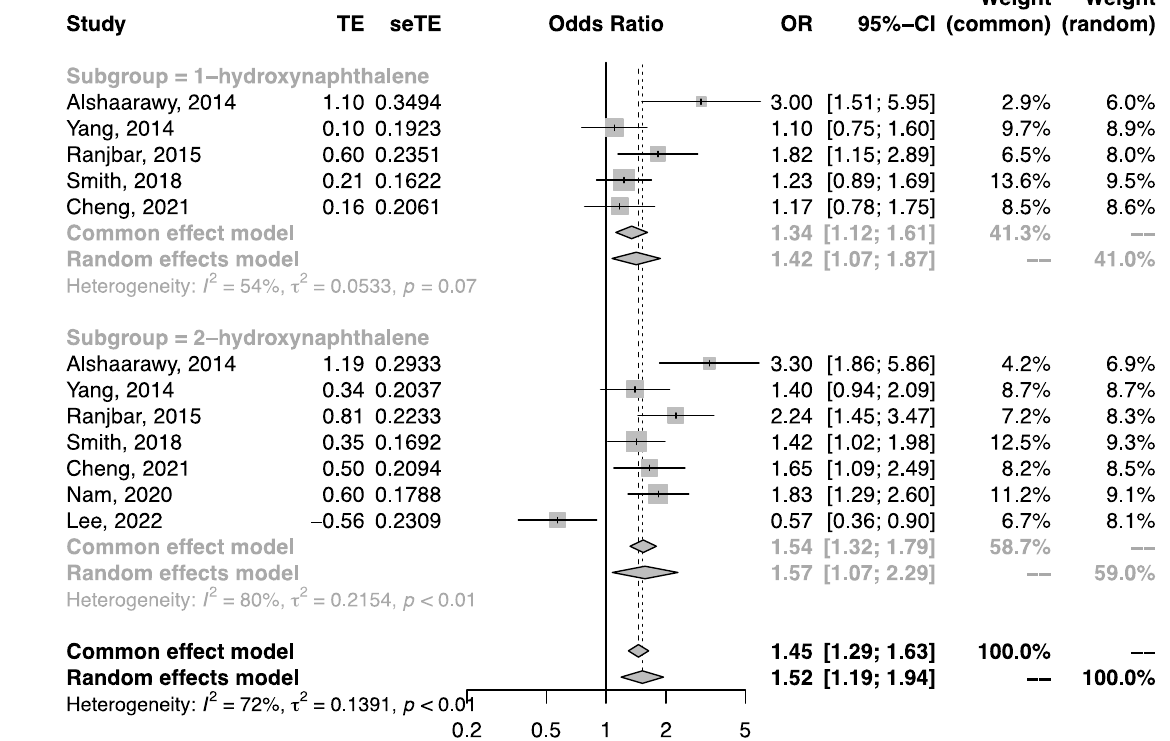
Figure 2. The association between urinary NAP metabolites and risk of T2DM [20–25,28].